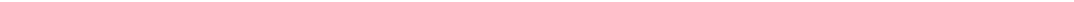
Fig. 3 Increased substrate stiffness and actomyosin contractility enhance APC-dependent RNA localization. a Left panel: schematic depicting changes in PDI index values for the indicated hypothetical RNA distributions. Higher PDI values re fl ect more peripheral RNA distributions. Middle panel: in situ hybridization of Ddr2 RNA (localized, cyan) and polyA RNA (control, magenta) in a representative cell on glass. Right panel: corresponding PDI values from a population of cells. Note that, in order to compare cytoplasmic distributions, signals within the nuclear area are subtracted prior to calculation of PDI values. This creates an apparent increase in PDI, which is disproportionately observed on 1kPa substrates (e.g., in panels b , h ), because of the larger relative area covered by the nucleus. b Representative Ddr2 and polyA RNA distributions on substrates of varying stiffness, and corresponding PDI values. Arrows point to peripheral Ddr2 RNAs. c Traction force microscopy analysis on substrates of the indicated stiffness. d Representative Ddr2 RNA distributions and PDI values of cells treated with blebbistatin (Bleb) or Y27632, plated on 5 kPa substrates. e Traction force microscopy analysis of cells treated as in d . f Representative Ddr2 RNA distributions and PDI values of control cells or cells knocked-down for Myosin heavy chain IIA, Myh9, plated on 5kPa substrates. g Traction force microscopy analysis of cells treated as in f . h Representative Ddr2 RNA distributions and PDI values of control cells or cells treated with LPA or Rho activator II, plated on 1 kPa substrates. i Traction force microscopy analysis of cells treated as in h . For all PDI quanti fi cations, bars represent the mean with 95% con fi dence interval. Points indicate individual cells analyzed in at least two or more independent experiments. For all traction force analyses, error bars represent standard error and n -values are indicated within each bar. p -values: **** < 0.0001, *** < 0.001, ** < 0.01, * < 0.05 by analysis of variance ( b – f , h , i ) or Mann – Whitney test ( g ). Scale bars: 10 μ m. Yellow lines: cell outline; white dashed line: nuclear